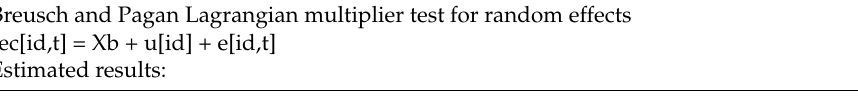
Table A4. Breusch and Pagan Lagrangian multiplier test for random effect for model 2. Breusch and Pagan Lagrangian multiplier test for random